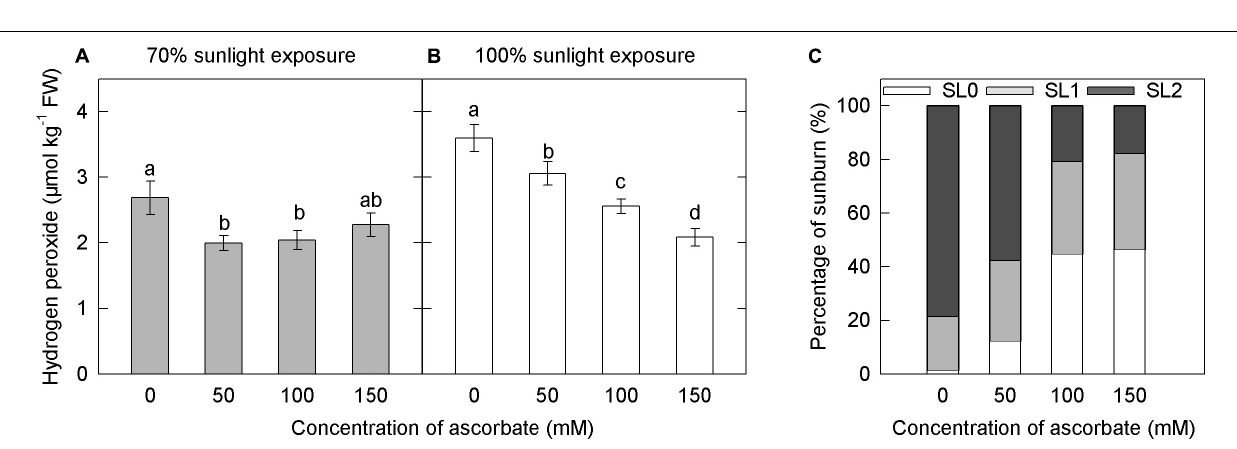
70% light intensity than under natural light (Duncan’s test was used for the statistical analysis), and H 2 O 2 content decreased with increasing exogenous ascorbate concentration